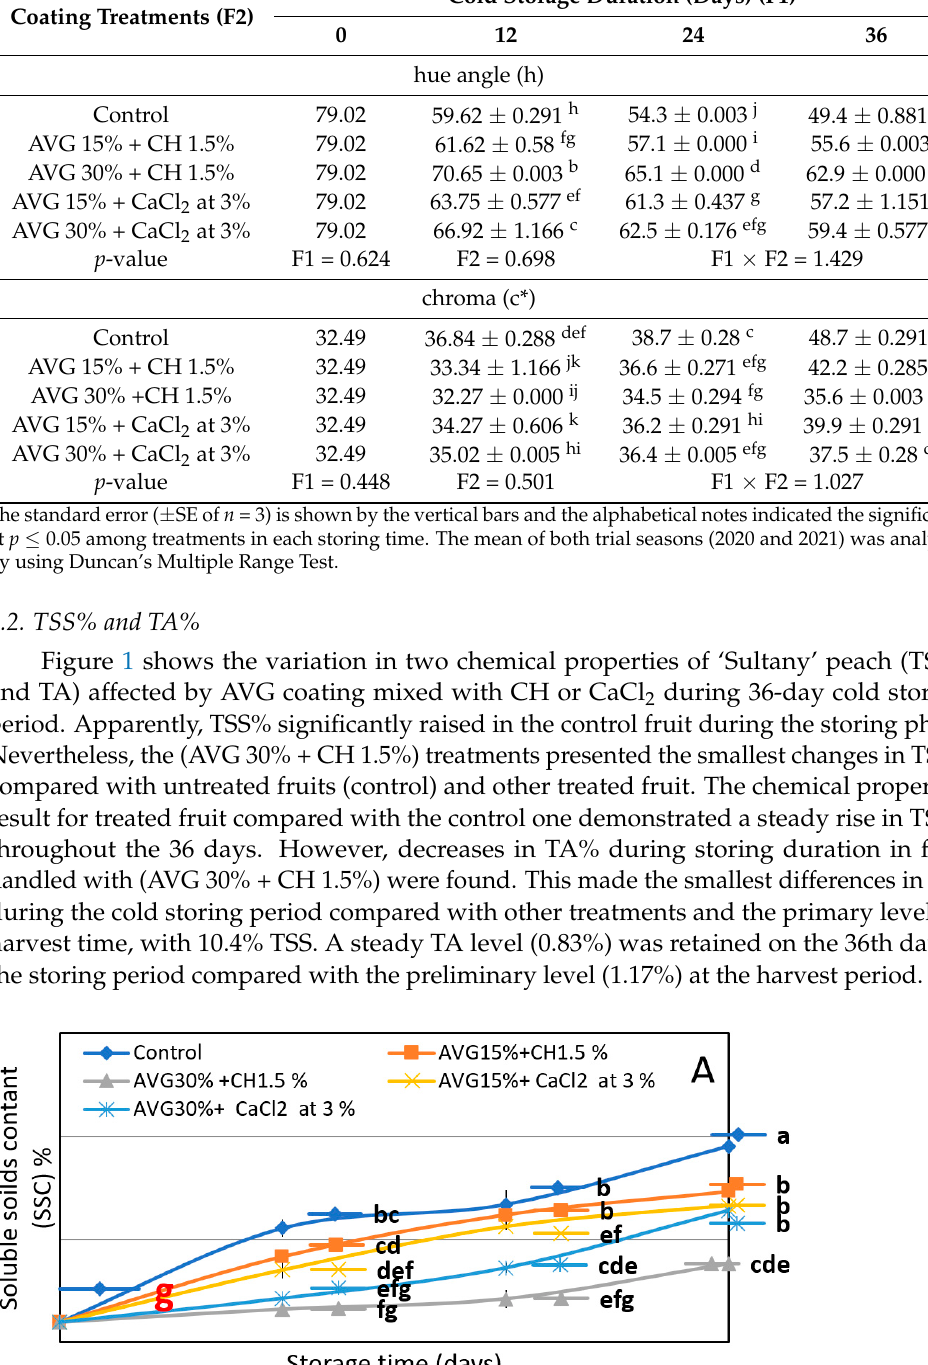
Figure 1. The effect of coating with AVG at 15 and 30% mixed with CH at 1.5% or CaCl 2 at 3% on TSS% ( A ), and TA% ( B ) of ‘sultany’ peaches during cold storing at 3 ± 1 °C and 95 ± 1% RH for 36 days. The standard error (±SE of n = 3) is shown by the vertical bars, and the alphabetical letters indicated the significance at p ≤ 0.05 among treatments in each storing period. The average of both trial seasons (2020 and 2021) was analyzed by using Duncan’s Multiple Range Test. p -value of TSS%, F1 = 0.448 F2 = 0.501 F1 × F2 = 1.027 and TA%, F1 = 0.033 F2 = 0.037 F1 × F2 = 0.076. 3.3. Analysis of Ion Leakage (IL%) and Malondialdehyde (MDA) Accumulation Figure 2 shows the incremental increase in IL% and MDA accumulation in peach tissue during the storing period (36 day), based on the storing duration and treatments. Peach fruits coated with a combination of (AVG 30% + CH 1.5%) significantly minimized the levels in IL% and MDA (19.23% and 0.28 µM g − 1 FW) compared with the initial values. The greatest IL and MDA content (48.62% and 0.49 µM g − 1 FW) was noticed in the raw fruits (control) at the end of the cold storing period. The variations among the treatments also occurred on the 12th day and developed to be more pronounced during the storing period until the ending of the investigation. Thus, these findings showing that the blended influence of both coating reasons (AVG 30% + CH 1.5%) retained the membrane reliability of treated peaches.